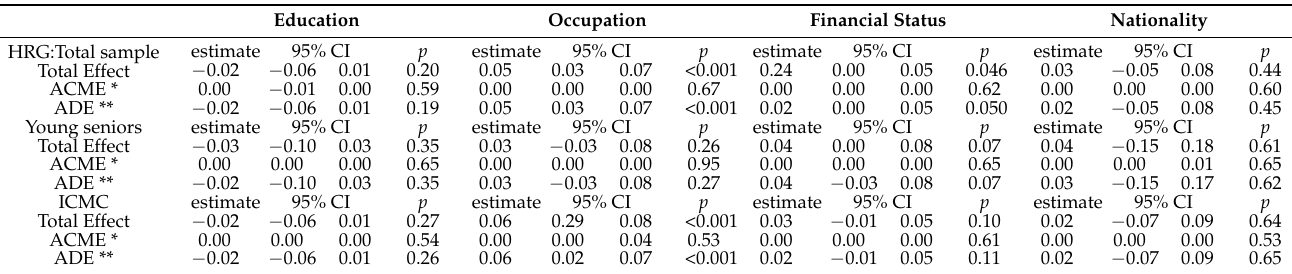
Table 4. Mediation analyses: Mediation effect of health literacy in the association between SES factors (education, occupation, financial status, nationality; independent variables) and influenza vaccination status in high-risk groups (HRGs): Total, Young seniors, and Individuals with chronic medical conditions